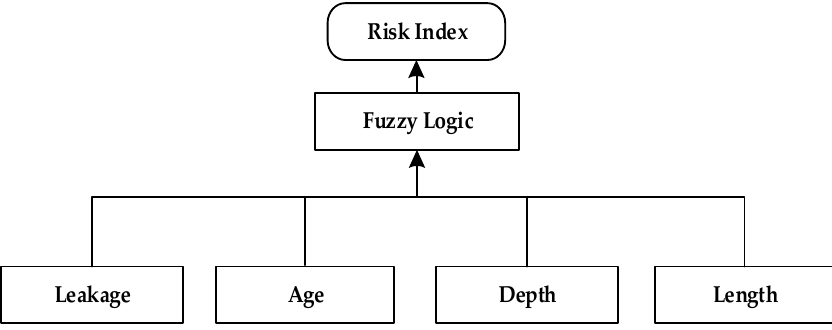
Figure 2. Conventional fuzzy logic model for four input parameters.